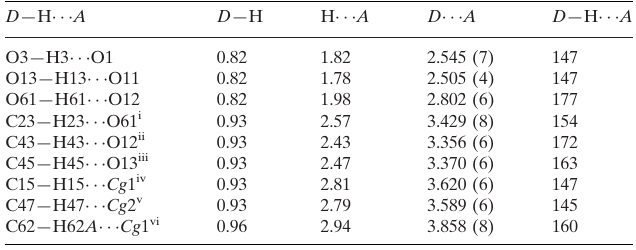
Hydrogen-bond geometry (A˚ , (cid:4)